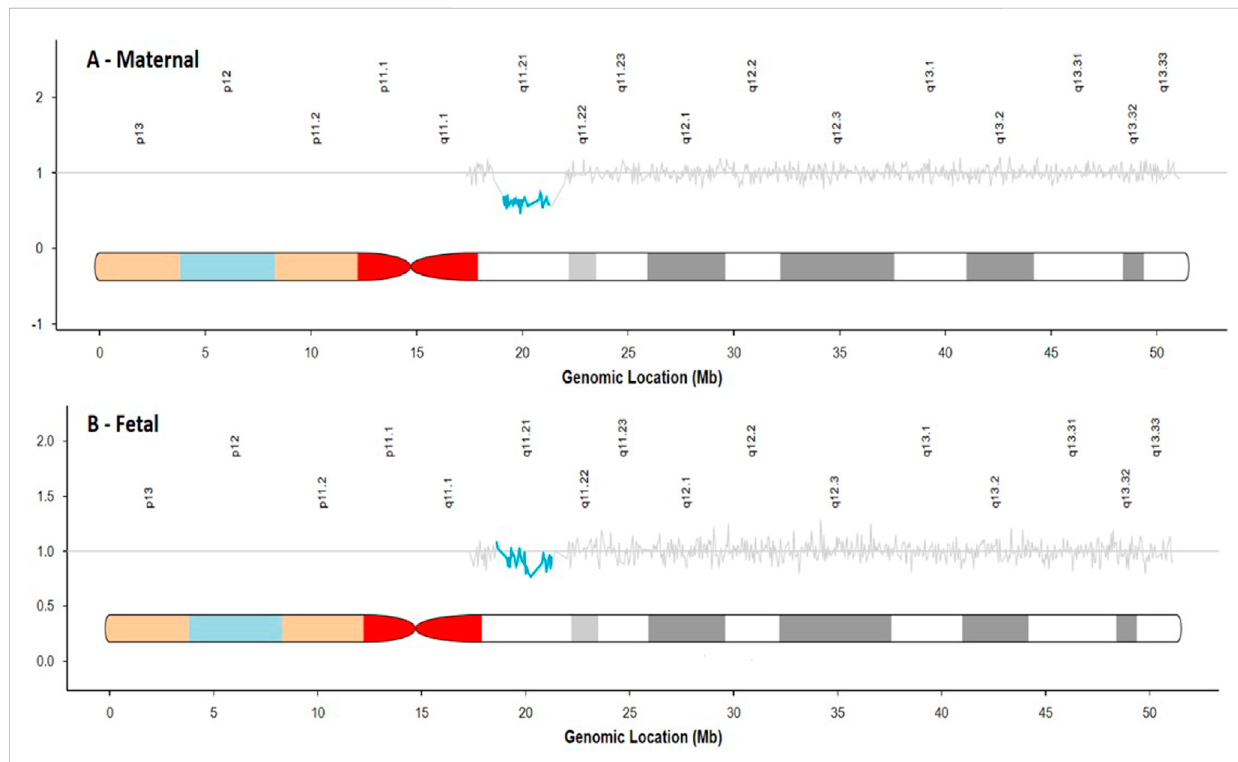
FIGURE 2 Comparison of sequencing traces for a suspected maternal deletion (A) and suspected fetal deletion (B)